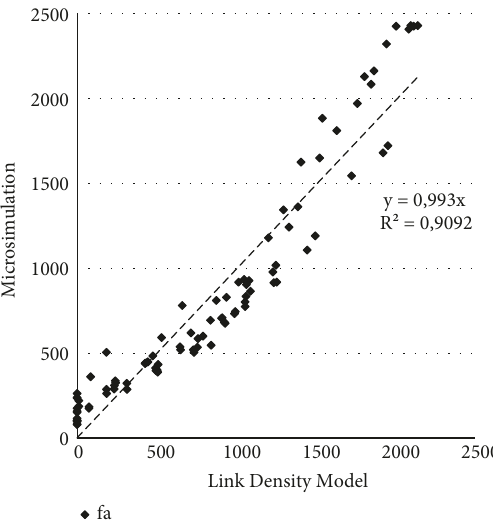
Figure15:LinkCostDispersion:MicrosimulationvsDensity-Based Model.